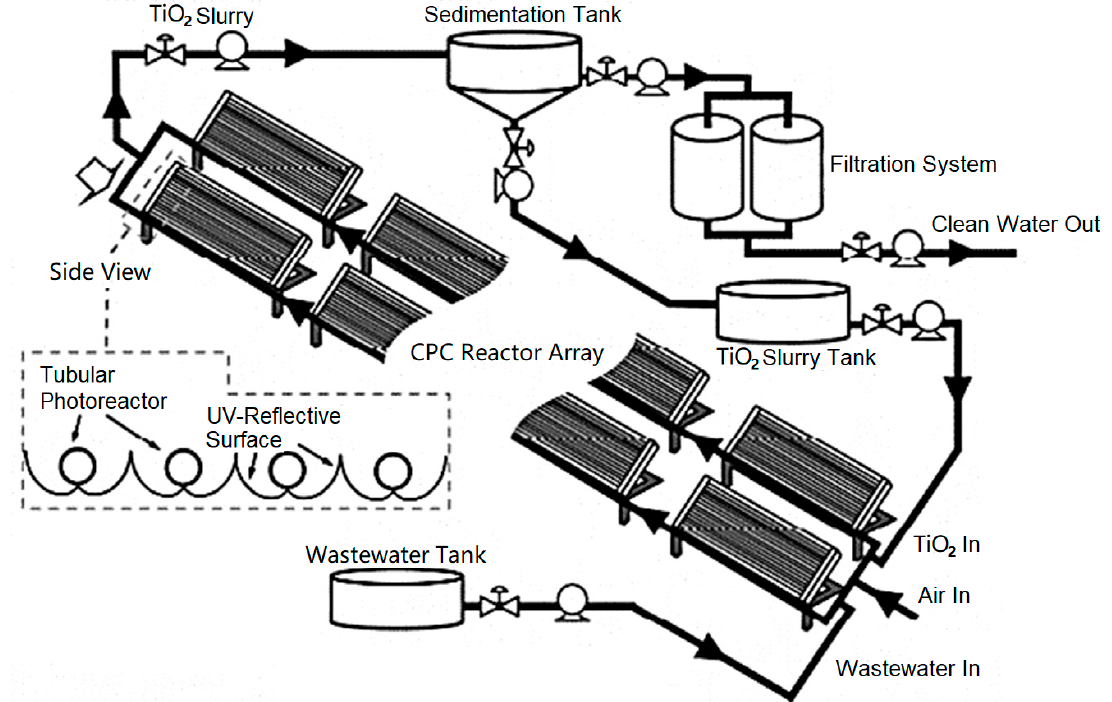
Figure 41. Schematic diagram of a photocatalytic water purification system with CPC reactor [77].